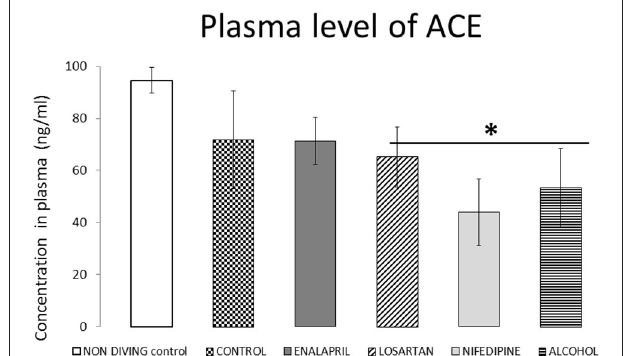
FIGURE 5 | TBARS plasma levels for all diving groups with treatment compared with diving control and non-diving rats. TBARS plasma levels expressed as µ M (mean ± SEM), for all the diving groups with treatment compared with diving control and non-diving rats. * p < 0.05.